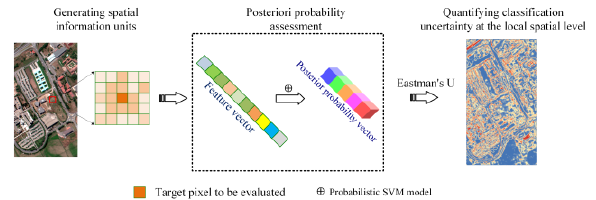
Figure 3. Flowchart of the classification